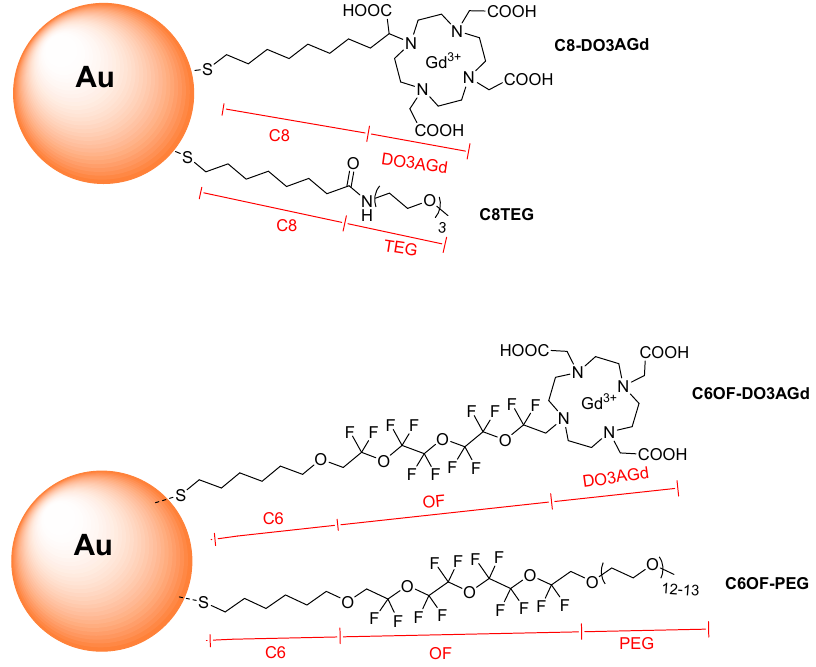
Scheme 1. Structure of thiolated ligands used in this study to prepare gadolinium-functionalized nanoparticles.